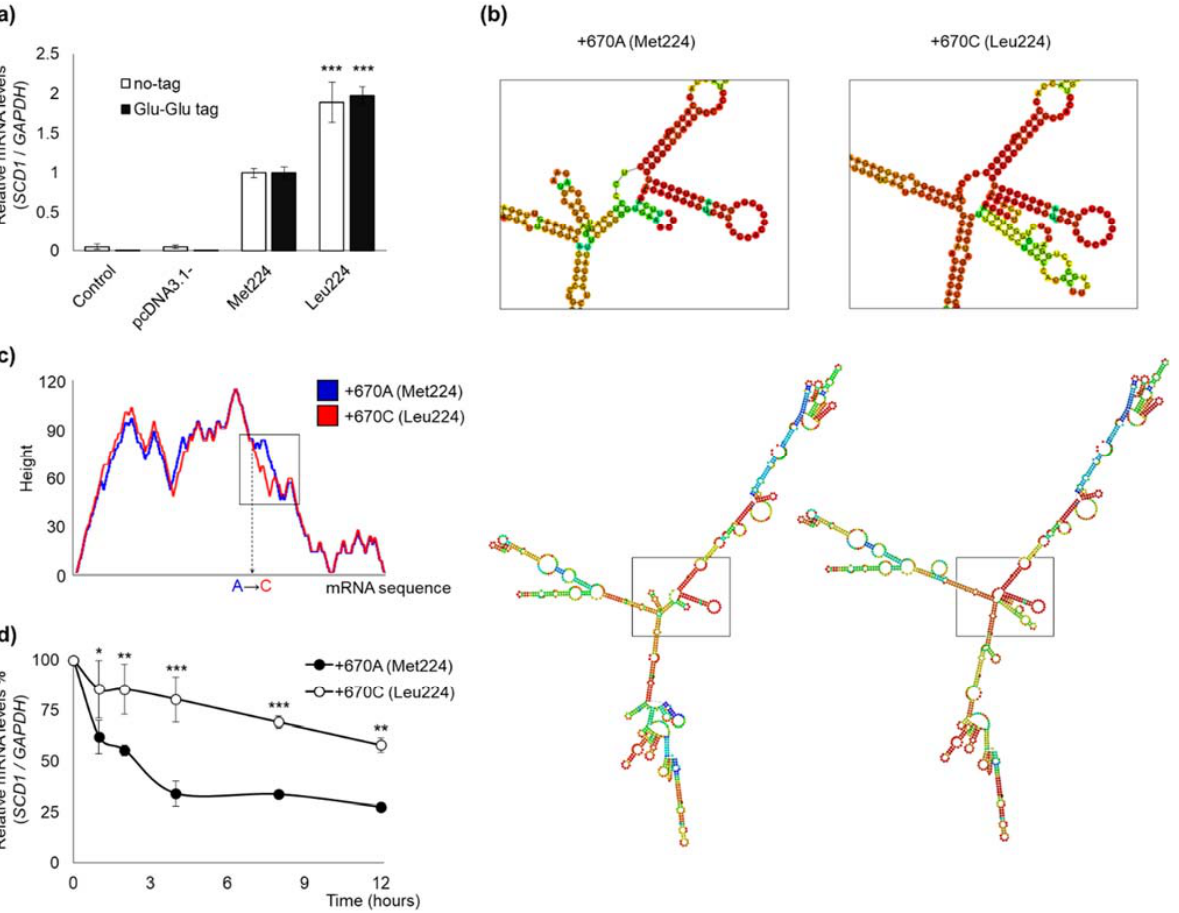
Figure 2. mRNA levels and structures of rs2234970 polymorphic SCD1 variants. ( a ) The mRNA level was measured in transiently transfected HEK293T cells. Samples were harvested and prepared as described in Section 4. qPCR was carried out using GAPDH , SCD1 and Glu-Glu tag sequence specific primers as indicated in Section 4. The diagram presented depicts the results of three independent measurements. Statistical analysis was performed with the Tukey–Kramer Multiple Comparisons Test. Data are shown as mean values ± S.D. *** p < 0.001. ( b ) The secondary MFE structures of +670A and +670C SCD1 were predicted by RNAfold server as indicated in Section 4. mRNA numbering begins at the first nucleotide of the start codon. The difference in the secondary structure of mRNAs is magnified in the left corner of the figure. ( c ) Mountain plot representation of MFE structure. The mountain plot represents a secondary structure in a plot of height vs. position, where the height is given by the number of base pairs enclosing the base at given position. Loops corresponding to plateaus, hairpin loops to peaks, and helices to slopes. The position of the polymorphic nucleotide change is indicated on horizontal axis. Red line: +670A; blue line: +670C. ( d ) HEK293T cells were transiently transfected with Glu-Glu tagged Met224 and Leu224 expressing constructs. 24 h after transfection cells were treated with actinomycin D (5 µ g/mL) for 0, 1, 2, 4, 8, or 12 h. Samples were harvested and prepared as described in Section 4. qPCR was carried out using GAPDH and Glu-Glu tag sequence specific primers as indicated in Section 4. The diagram presents the average of three parallels. Statistical analysis was performed with the Tukey–Kramer Multiple Comparisons Test. Data are shown as mean values ± S.D. * p < 0.05; ** p < 0.01; *** p < 0.001. Since the mRNA molecules of A (Met224) and C (Leu224) desaturase are otherwise identical (i.e., they possess the same 5 (cid:48) UTR, 3 (cid:48) UTR regions, and polyA tail) in vivo as